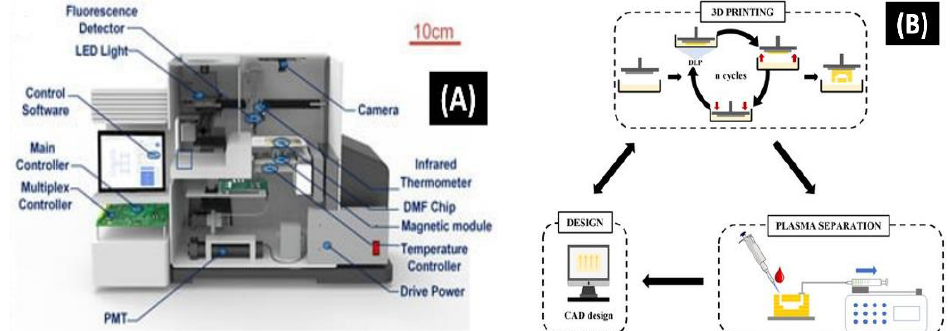
Figure 8. ( A ) Structure diagram of an all-in-one system for sensing nucleic acid using LAMP [156]. ( B ) The 3-D-printed microfluidic analytical devices are applied for plasma separation and the iterative fabrication process workflow [157].